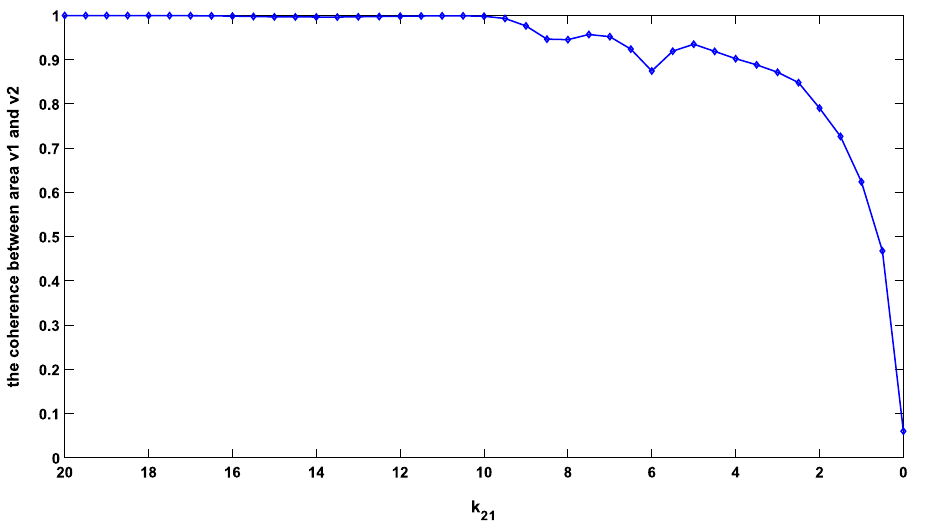
Figure 4. Coherence between areas v2 and v1 with k 21 changing from 20 to